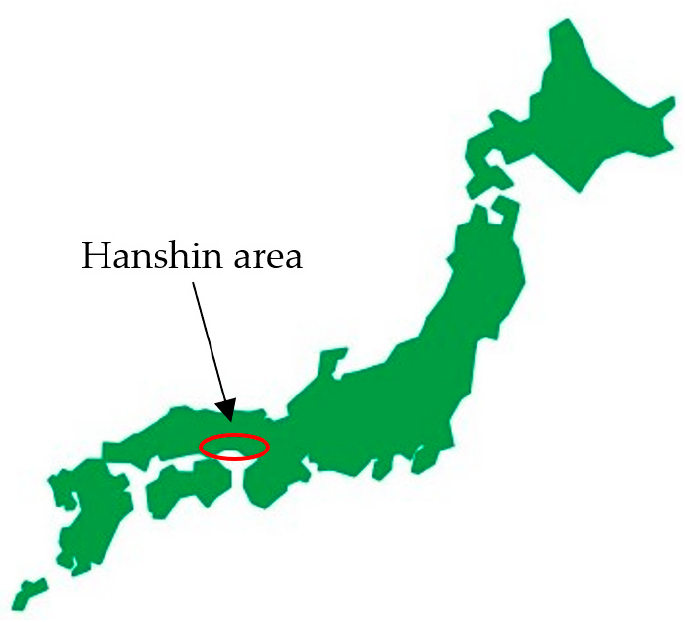
Figure 1. Location of Hanshin area in Japan. The map was obtained from the internet (https://nureyon.com/japanese_archipelago-1?pattern=12 (accessed on 27 September 2021)).